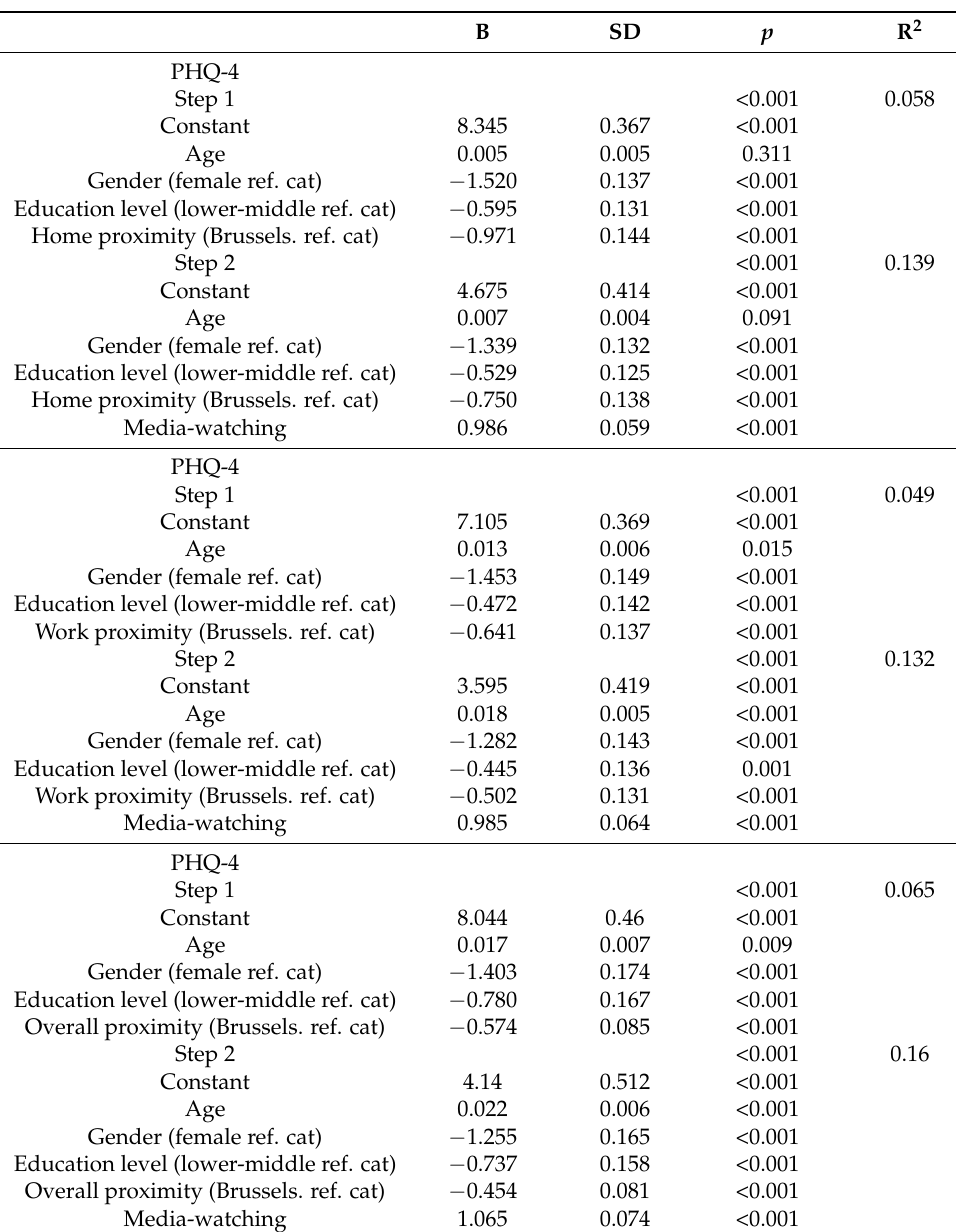
Table 6. Regression